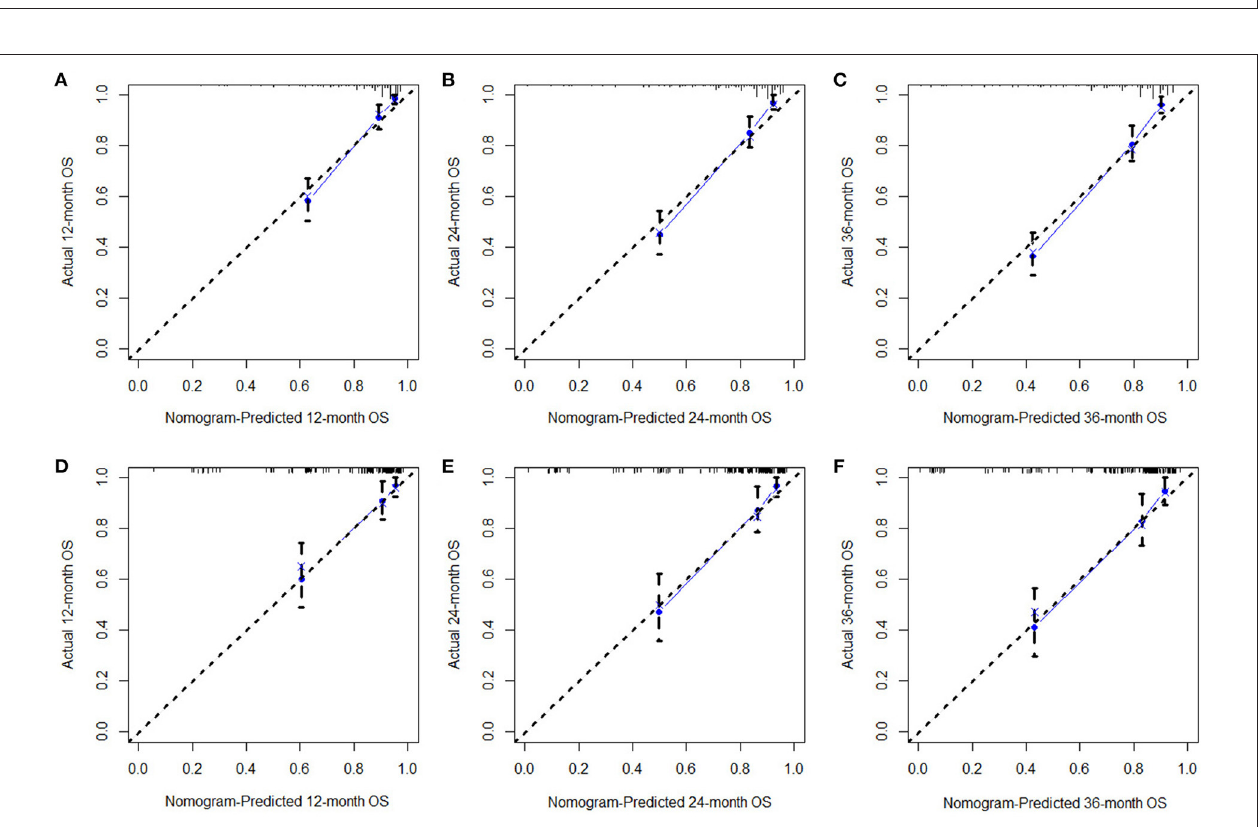
FIGURE 6 | The calibration curves of 12- (A) , 24- (B) , 36-month (C) , OS in the training group and 12- (D) , 24- (E) , and 36-month (F) OS in the validation group. The dashed line represents an excellent match between nomogram prediction (X-axis) and actual survival outcome (Y-axis). The cohort was divided into five groups with equal sample size for internal validation. Closer distances from the points to the dashed line indicate higher prediction accuracy.